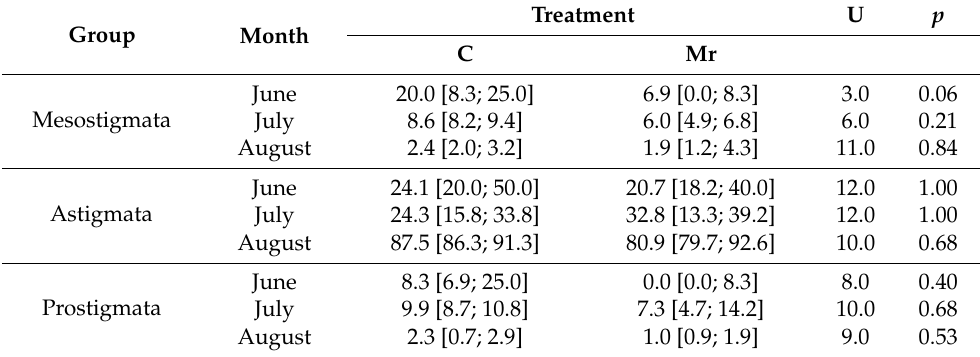
Table 6. Cont . Group